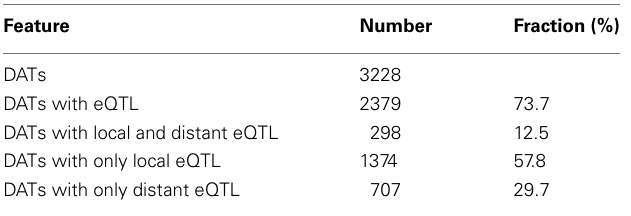
Table 1 | eQTLs mapped in 120 RILs exposed to low light conditions. Table 2 | eQTLs of L er /Cvi differentially abundant transcripts (DATs) in response to low light